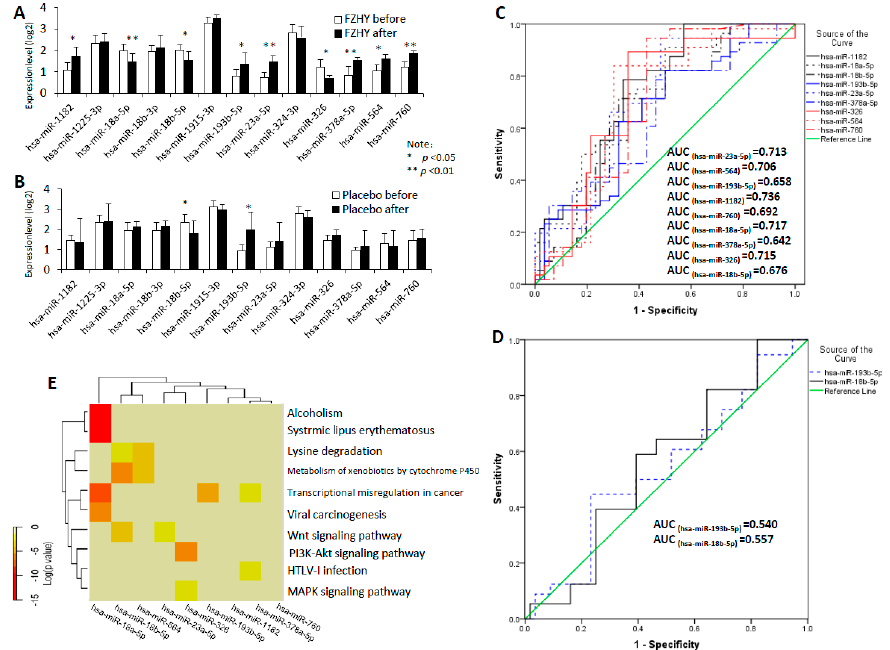
Figure 4. The potential kernel miRNAs were validated using the qPCR method. ( A ) Expression levels of 13 kernel miRNAs in the FZHY group. Illustrated p -values are based on pair-wise comparisons by the Mann–Whitney U -test. The result show that hsa-miR-1182, -18a-5p, -18b-5p, -193b-5p, -23a-5p, -326, -378a-5p, -564 and -760 ( p < 0.05) have a statistically significant difference, while has-miR-1225-3p,